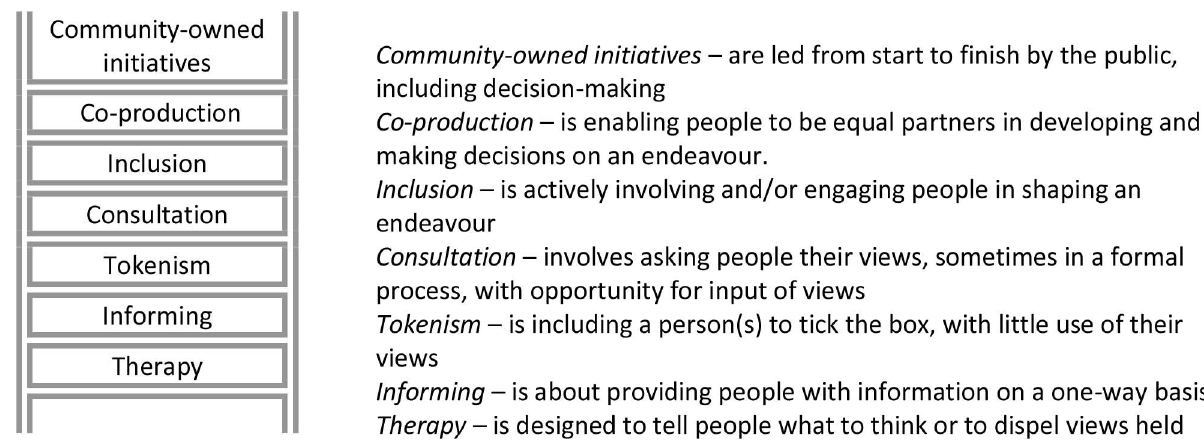
Figure 1: Ladder of public involvement & engagement